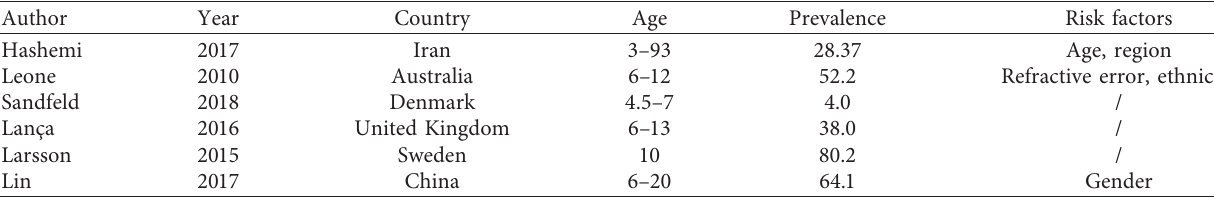
Table 7: Prevalence of heterophoria in previous studies.